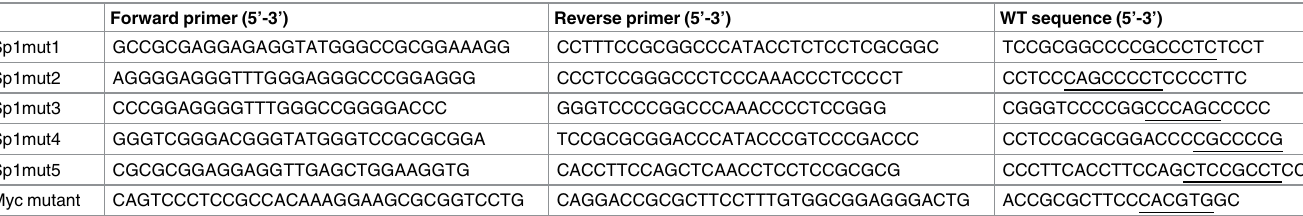
Table 2. Site-directed mutagenesis primers.